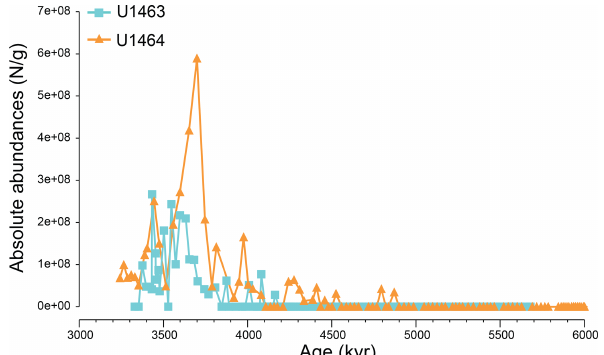
Figure A10. Absolute coccolith abundances (Ng − 1 × 10 8 ) of Pseu- doemiliania lacunosa plotted against sample age (kyr) at IODP Sites U1463 (blue squares) and U1464 (orange triangles).